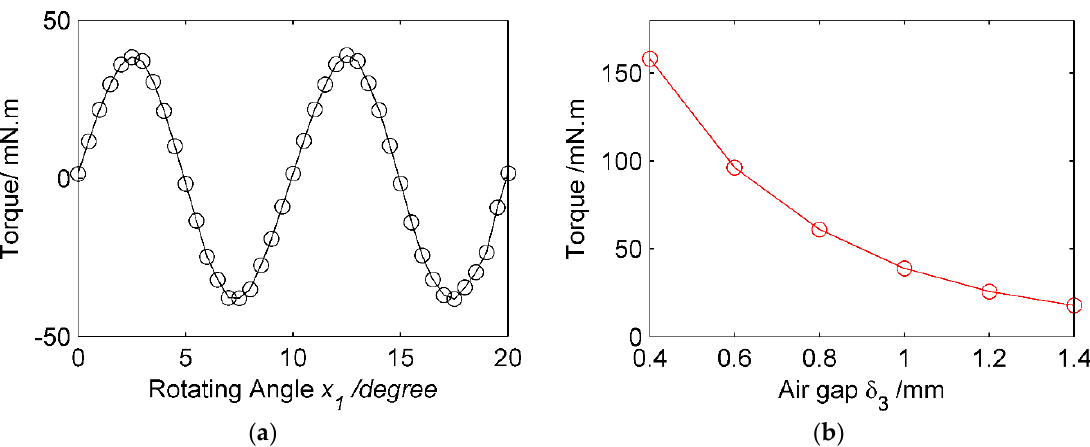
Figure 10. Analysis results of self-lock torque. ( a ) Variation of torque with rotating angle x 1 ; ( b ) Variation of torque with air gap δ 3 .